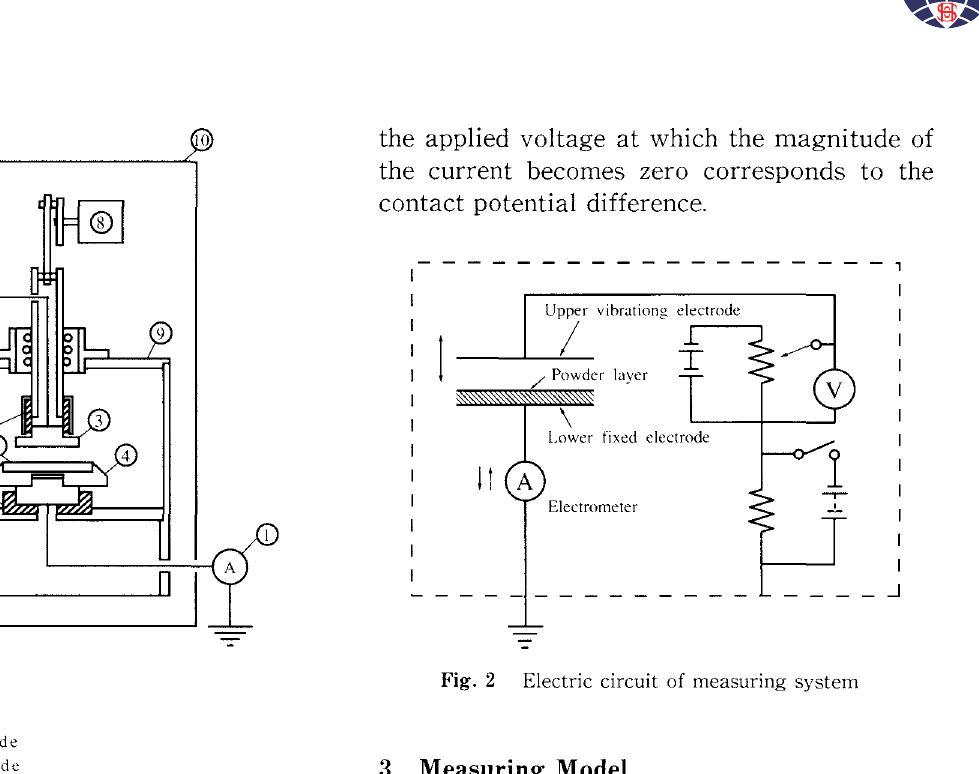
Fig. 2 Electric circuit of measuring system